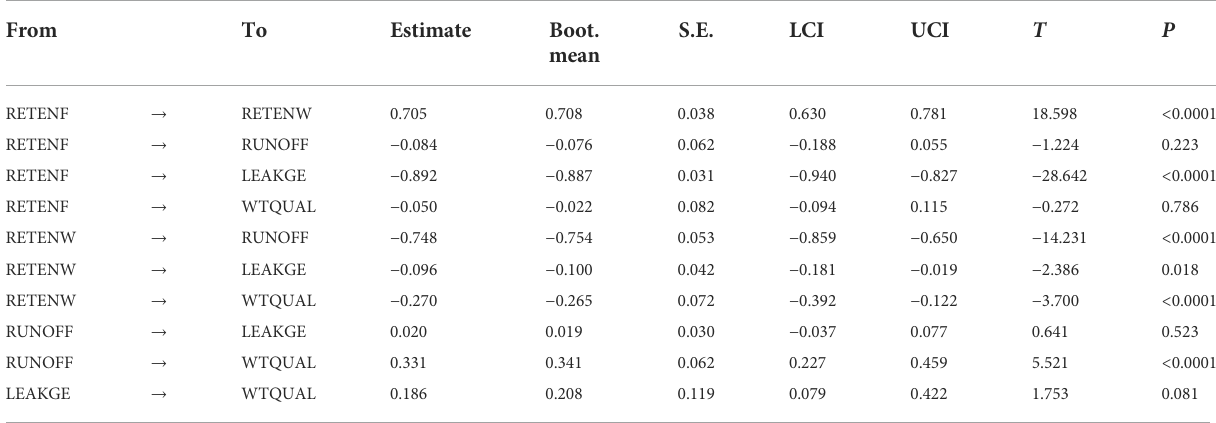
TABLE 6 Inner path coef fi cients of the fi nal (reduced variable) model. Estimates denote whether an antecedent latent variable ( ‘ From ’ column) positively or negatively affects the descendent variable ( ‘ To ’ column). Path weights are presented as estimates from 500 bootstrap estimates, accompaniedbyinterquartilecon fi denceintervals(LCI,UCI),associated T statisticsand P -values.Effectsthatarenotsigni fi cant( p < 0.05)aregrayed out for